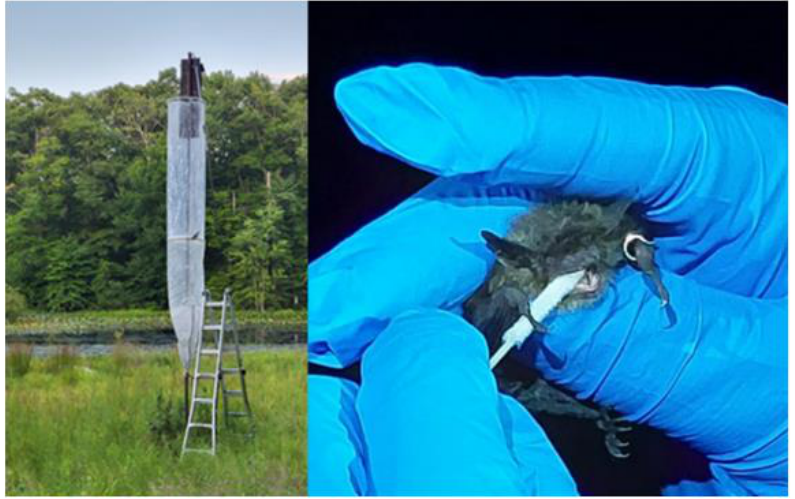
Figure 2. Left: Example of trap set up at a maternity colony in a bat box in New Jersey, 2022. Right: Oral swab collection from a little brown bat ( Myotis lucifugus ). Photo credit: J. De La Cruz. Table 1. Myotis lucifugus capture records from six states in the Northeast and Mid-Atlantic, USA, 2022.